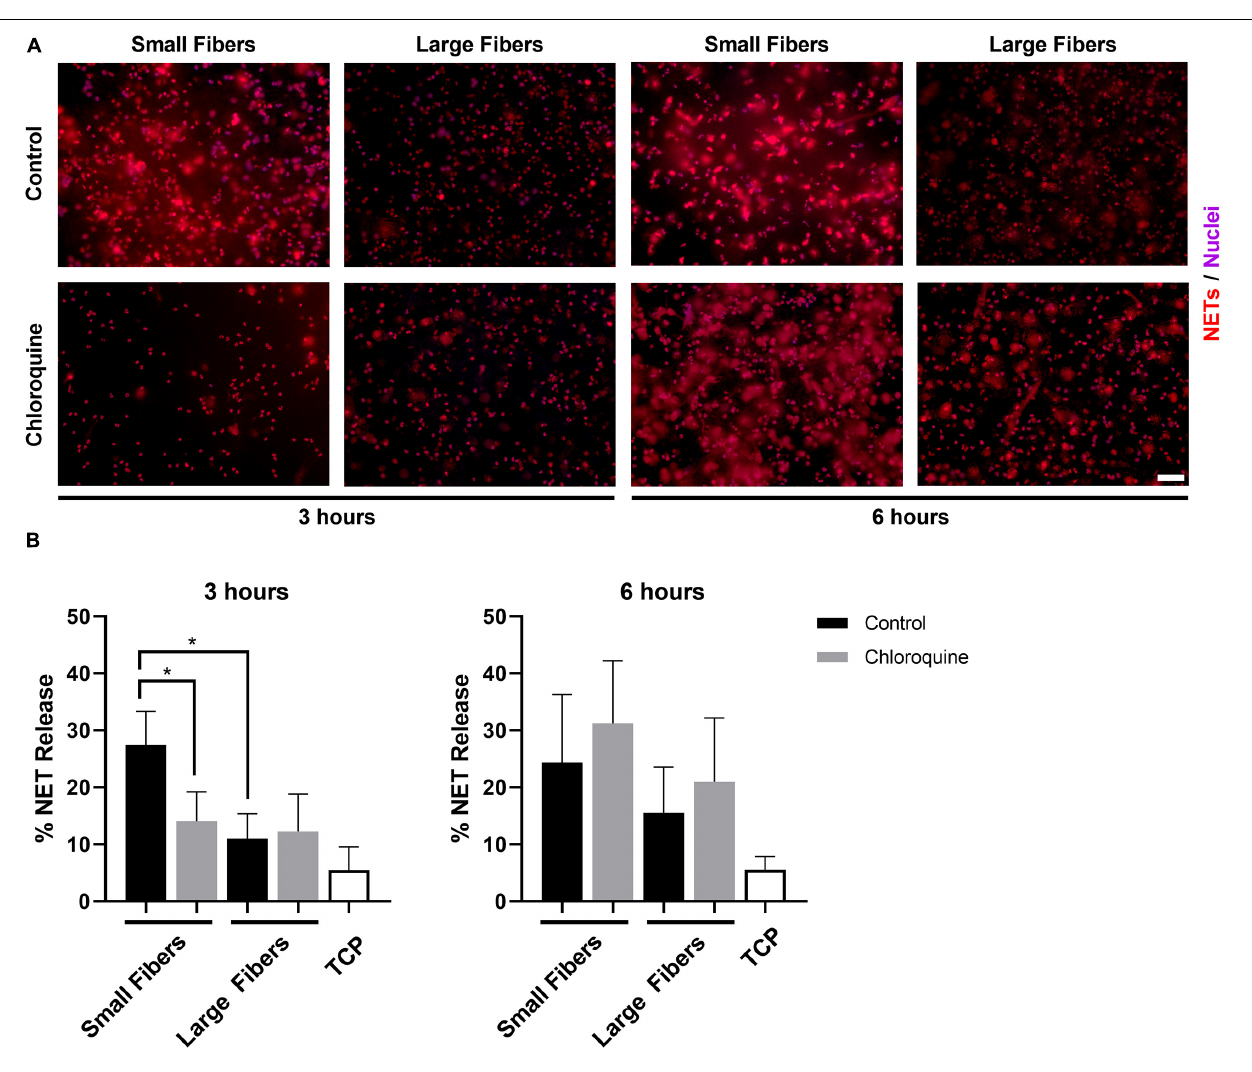
FIGURE 2 | Chloroquine elution inhibits NET release on small fibers but has no effect on large fibers. (A) Fluorescent micrographs of neutrophils on the electrospun biomaterials at 3 and 6 h after seeding. Staining of NETs (red) and nuclei (purple) reveals that chloroquine elution from the small fibers attenuates NET formation at the early time point, but not at the late time point. Conversely, chloroquine elution from the large fibers does not modulate NET release. Scale bar is 50 µ m. (B) Percent NET release at 3 h (left) and 6 h (right) as quantified by the ELISA for NET-disassociated MPO. The quantification of percent NET release ( n = 3) indicates that chloroquine elution from the small fibers reduces NET release to the level of the large fibers at 3 h with no effect at 6 h. The data represent the mean ± standard deviation of three independent experiments with unique donors. * p < 0.0001 was determined using an analysis of variance (ANOVA) and Holm–Sidak multiple-comparisons test. Raw data are available in Supplementary Spreadsheet 1